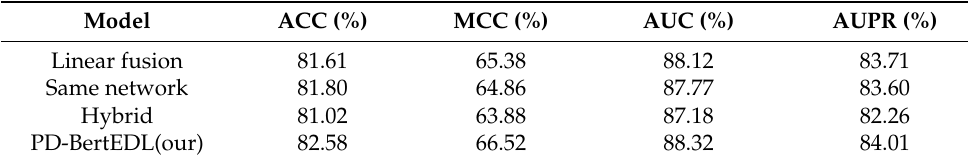
Table 3. The results of PD-BertEDL and other integration